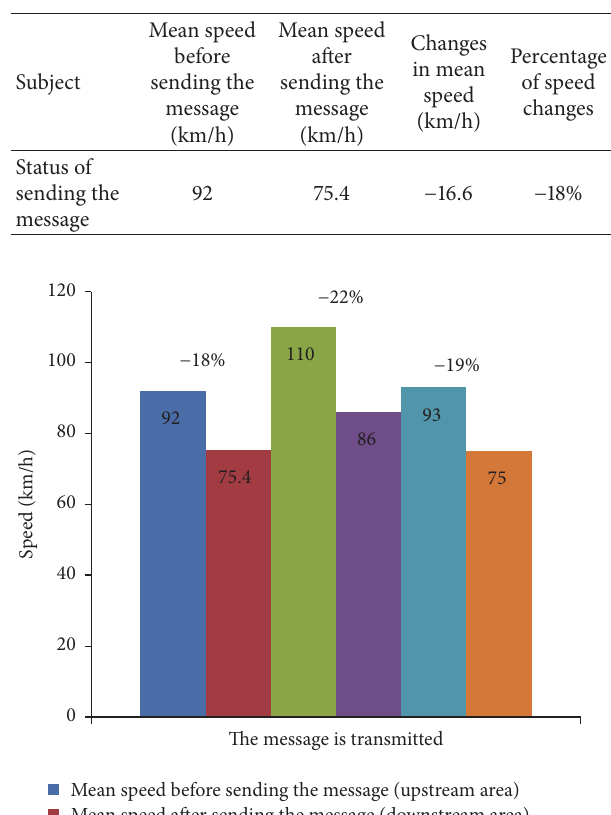
Table 3: Speed changes when massage is transmitted.